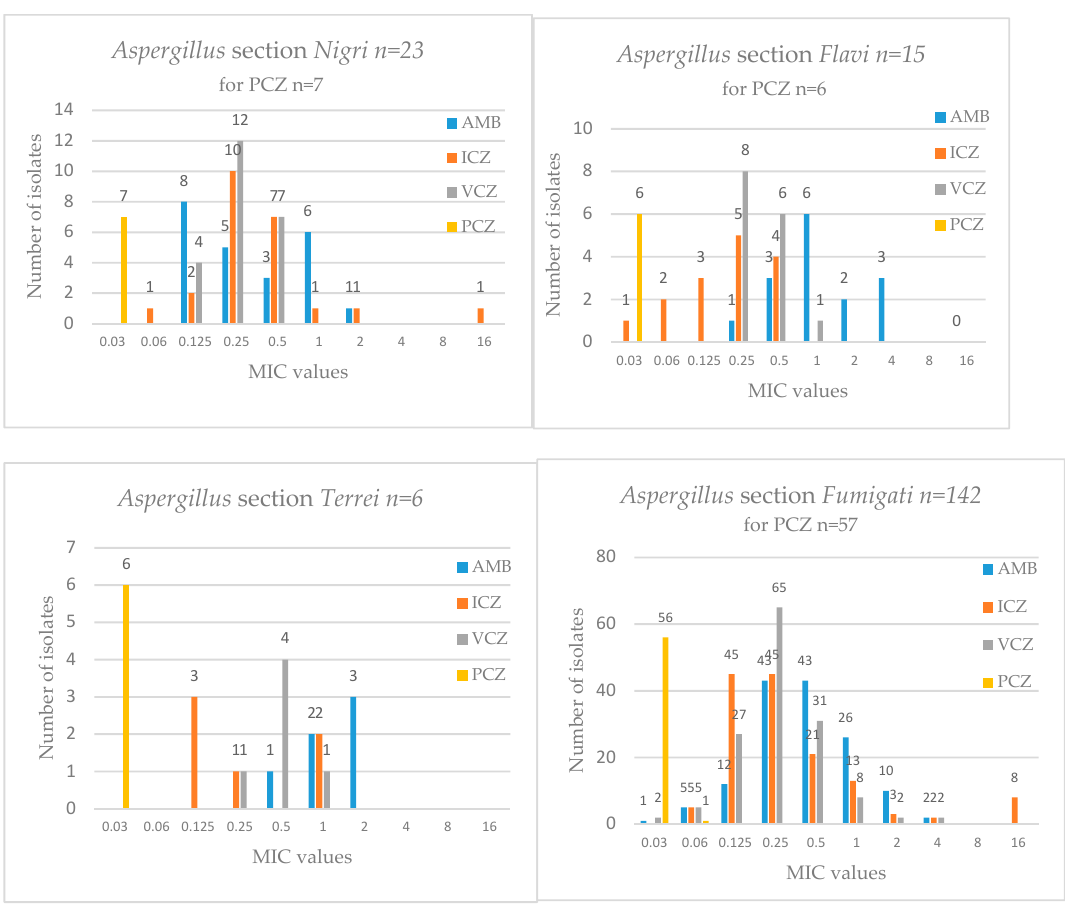
Figure 1. Number of isolates as a function of minimal inhibitory concentration (MIC) values for each drug and each species. AMB: Amphotericin B; ICZ: Itraconazole; VCZ: Voriconazole; PCZ: Posaconazole. Table 2. MIC50, MIC90, MIC mode and MIC range of the 4 antifungals tested for each species Section .